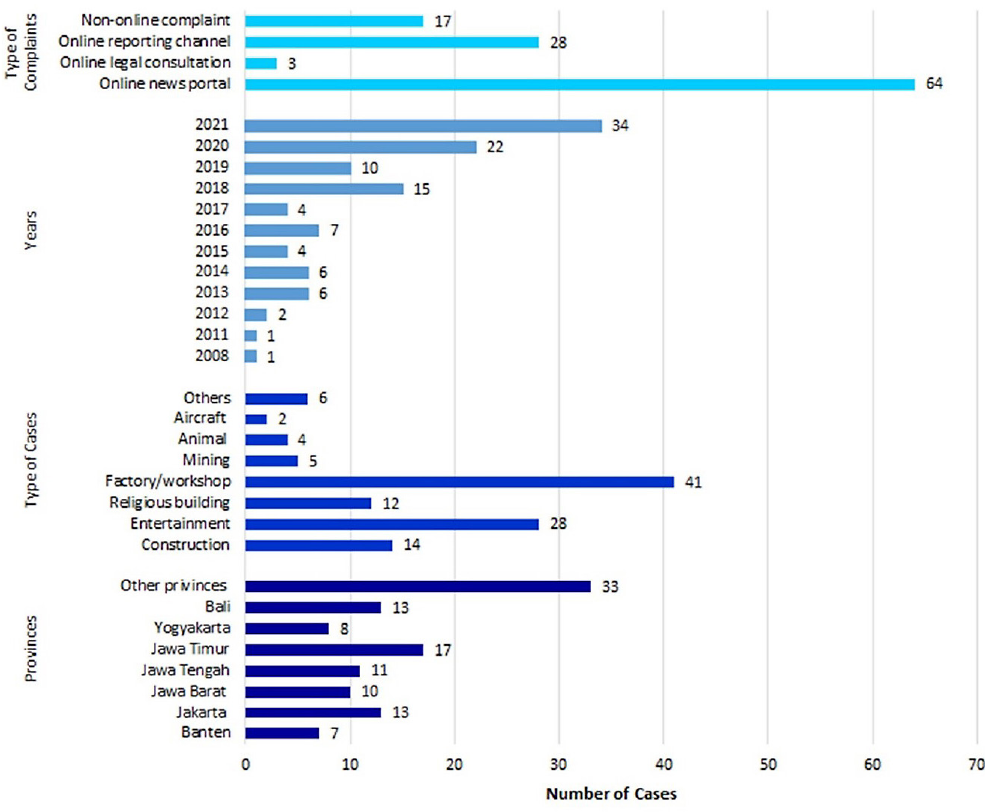
Figure 1. Noise complaints profile in Indonesia collected from year 2008 to